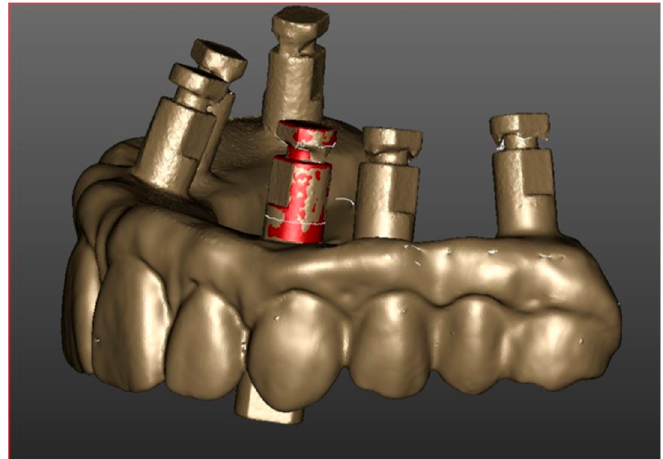
Figure 4. Precision match of intra and extraoral scan.